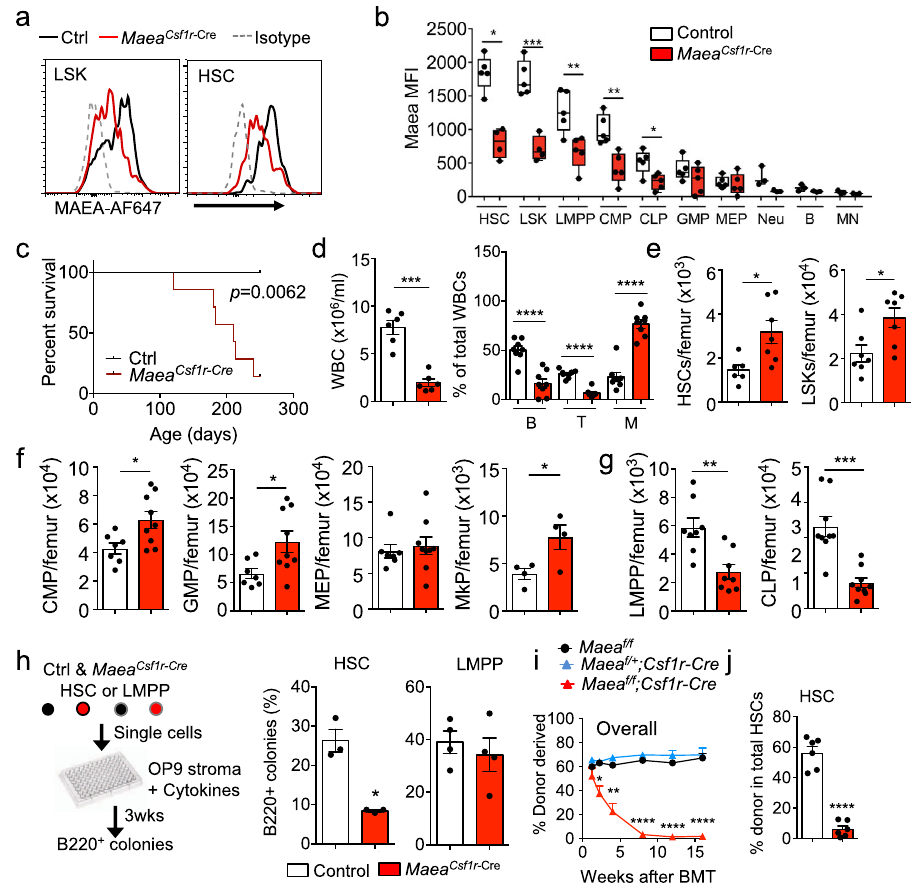
Fig. 1 MAEA expression is enriched and required in haematopoietic stem cells (HSCs) for haematopoiesis. a Representative histograms showing MAEA expression on lineage- Sca-1 + c-kit + progenitor cells (LSKs) and HSCs in control (Ctrl) and Maea Csf1r-Cre bone marrow (BM). b FACS quanti fi cation of MAEA expression on control ( n = 5) and Maea Csf1r-Cre ( n = 4) BM HSPCs (LMPP lymphoid-primed multipotent progenitors, CMP common myeloid progenitors, CLP common lymphoid progenitors, GMP granulocyte-macrophage progenitors, MEP megakaryocyte-erythrocyte progenitors), neutrophils (Neu), B cells (B) and monocytes (MN). Data are represented as boxes-and-whiskers with the whiskers span from minima to maxima of each dataset, the boxes extend from the 25th to 75th percentiles and the centre line indicates the mean. HSC p = 0.0202, LSK p = 0.0004, LMPP p = 0.0076, CMP p = 0.0016, CLP p = 0.0173. c The Kaplan – Meyer survival curve of control ( n = 8) and Maea Csf1r-Cre ( n = 6) mice. p value was calculated by log-rank test. d White blood cell (WBC) counts in peripheral blood ( n = 6 each group) and frequency of B, T and myeloid cells in total WBCs of young adult control and Maea Csf1r-Cre mice ( n = 8 each group). WBC p = 0.0001, B, T and M p < 0.0001. e Quanti fi cations of HSC and LSK numbers in BM of control ( n = 6) and Maea Csf1r-Cre mice ( n = 7). HSC p = 0.0165, LSK p = 0.024. f Quanti fi cation of myeloid progenitors in BM of control ( n = 6) and Maea Csf1r-Cre ( n = 9)